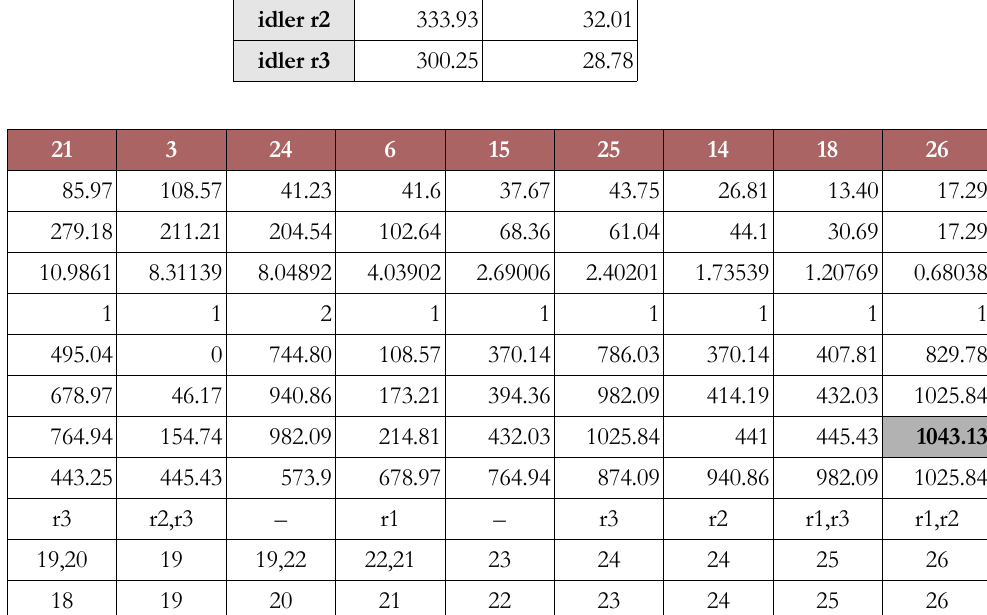
Table 17. ACTRES Scheduling, Rmax = 3, n(r) = 3 (Scenario